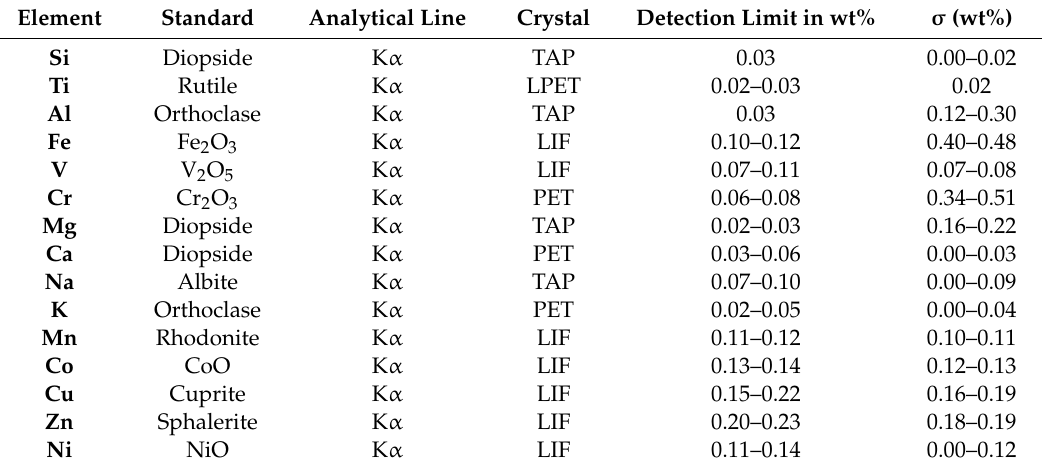
Table 1. Conditions of EPMA (Electron probe microanalysis )